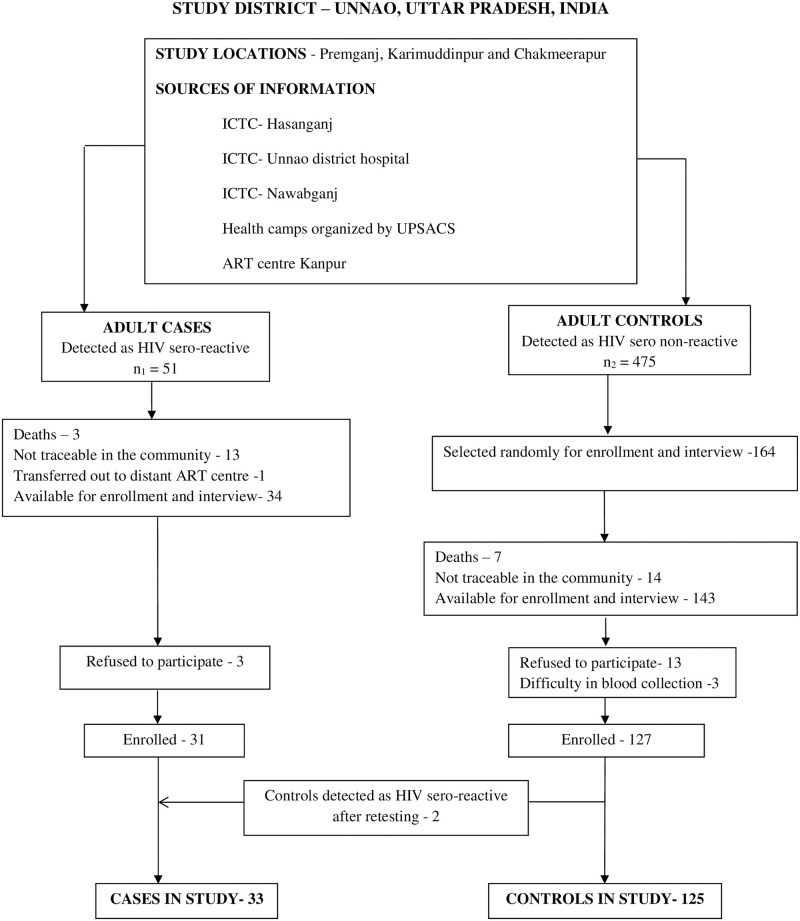
Flow chart—Recruitment of study population.